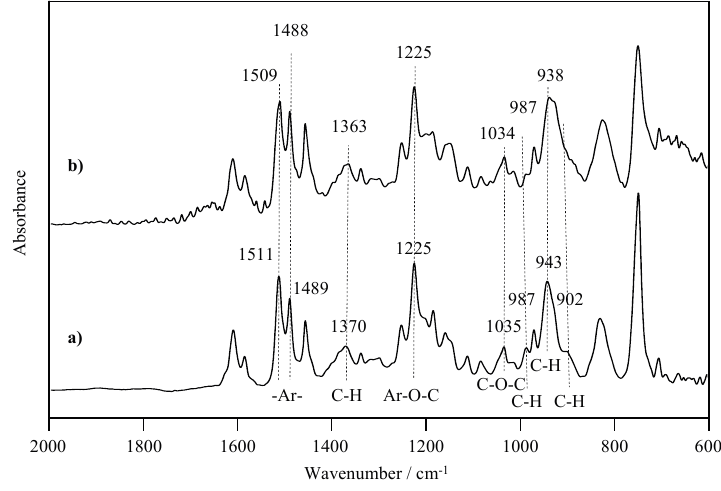
Figure 3. IR spectra of P-4va (a) and oligo(P-4va)